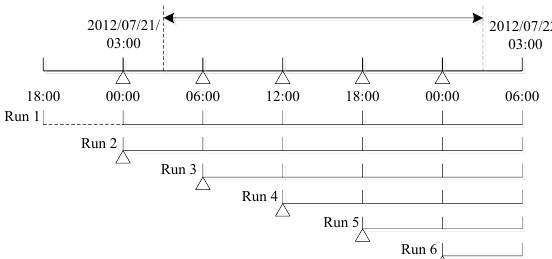
Figure 4. The time bars of the cycling WRF-3DVar runs.